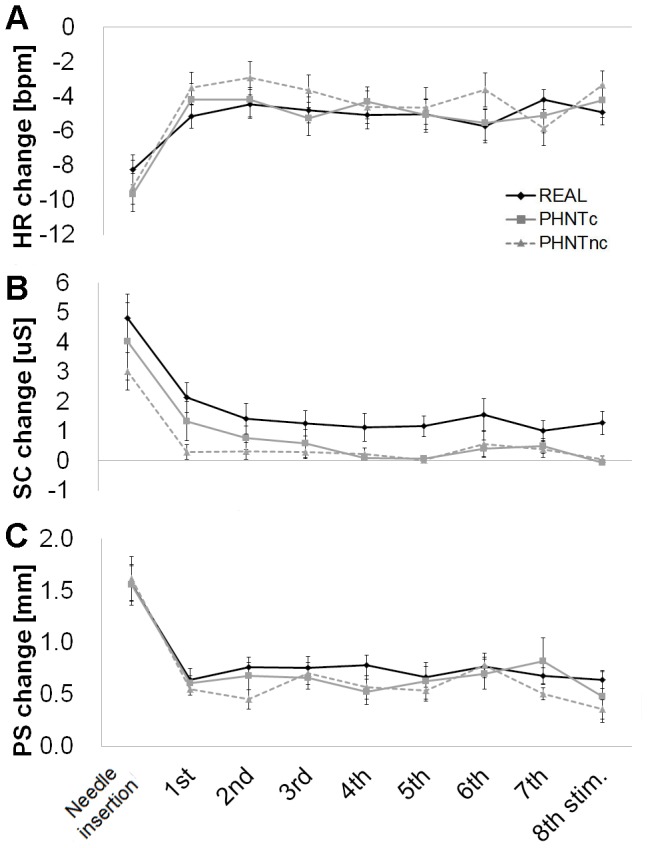
Temporal evolution of autonomic response to real (REAL) and phantom (credible, PHNTc; non-credible, PHNTnc) acupuncture.Needle insertion, whether real or phantom, produced significantly greater (A) HR decrease, (B) SC increase and (C) PS increase, compared to needle manipulation. ANS response to needle manipulation was relatively stable over all 8 manipulations for REAL (n = 20), PHNTc (n = 11), and PHNTnc (n = 9). SC increase was greater for REAL compared to PHNTc and especially PHNTnc, consistently over all stimuli. Error bars represent standard error of the mean.